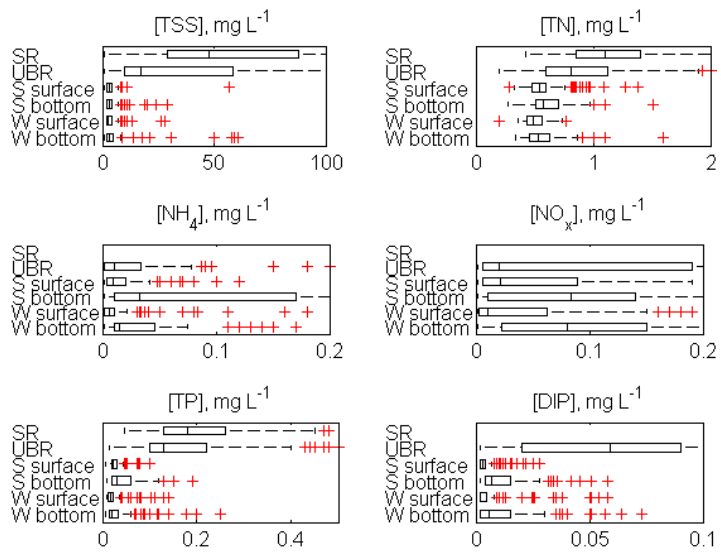
Figure 5. Concentration of total and dissolved inorganic nutrients measured at the dam walls of the Somerset and Wivenhoe reservoirs June 1997–July 2011, and at the gauging stations for Stanley River (SR) and Upper Brisbane River (UBR) July 2002–June 2009.